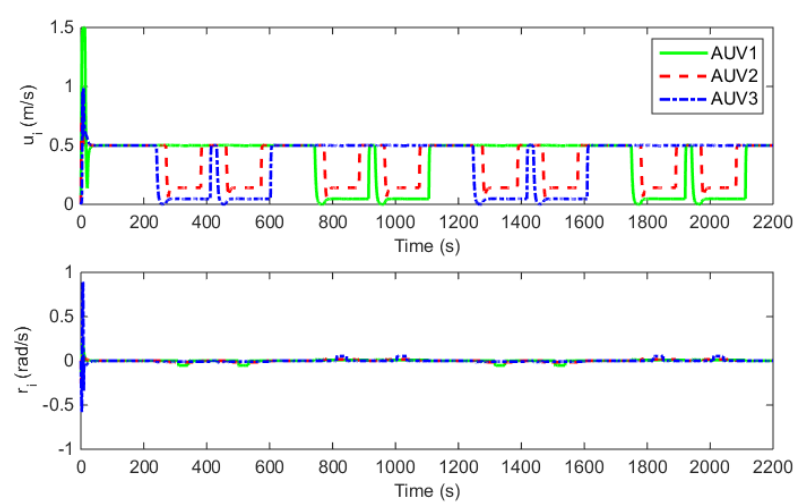
Figure 11. Surge and yaw angular velocities of three AUVs.